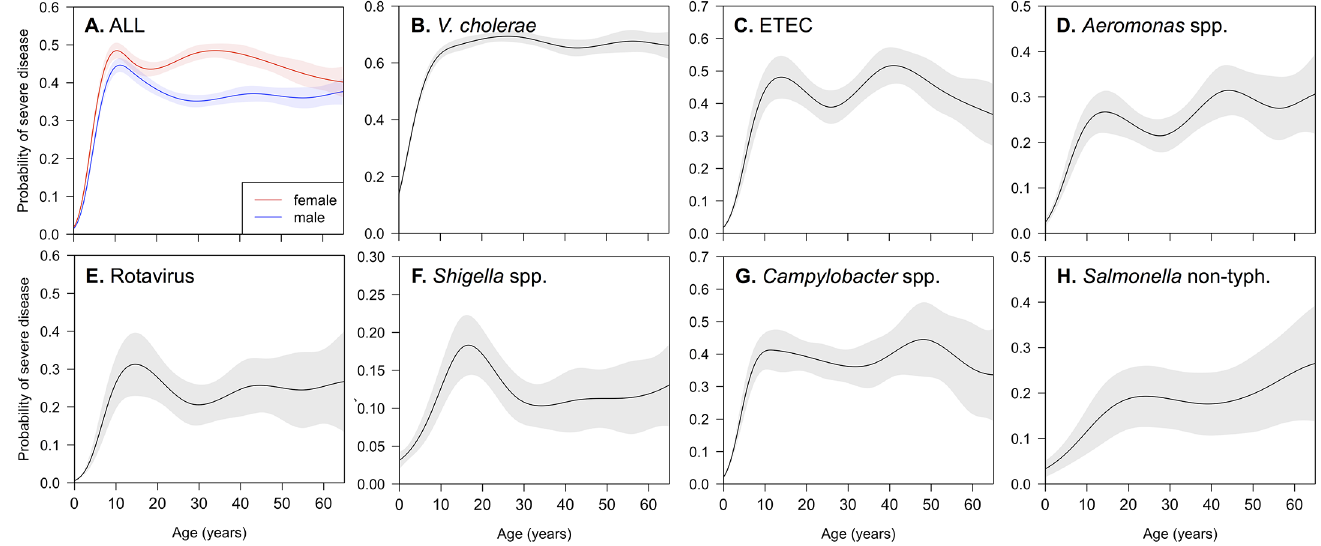
Fig 3. Predicted probabilityof severe dehydrationas a function of age, for all patients (A) or patients with specific pathogens (B-H). Panel A shows sex- stratified age-specific risks for all patients (male = blue, female = red). Shadingrepresentsthe 95% confidenceinterval.